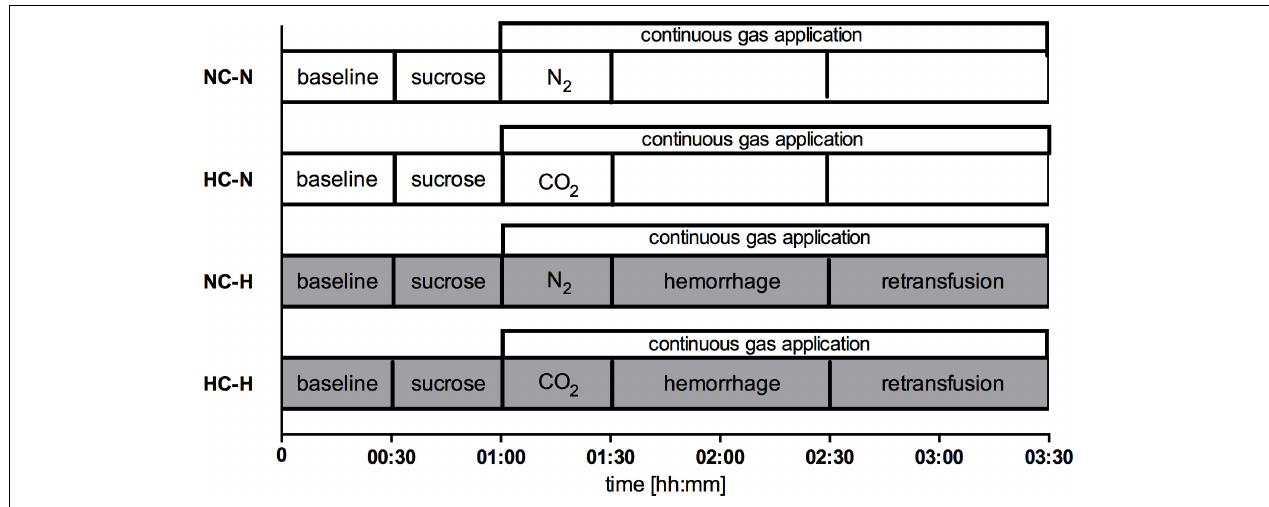
FIGURE 2 | Experimental protocol set 2: Continuous application of N 2 under normocapnia (NC) or hypercapnia with application of CO 2 (HC) before and during physiological (-N) or hemorrhagic (-H) condition. In shock groups 1 h of hemorrhage was followed by retransfusion, while gas application was conducted until the termination of the experimental protocol in all